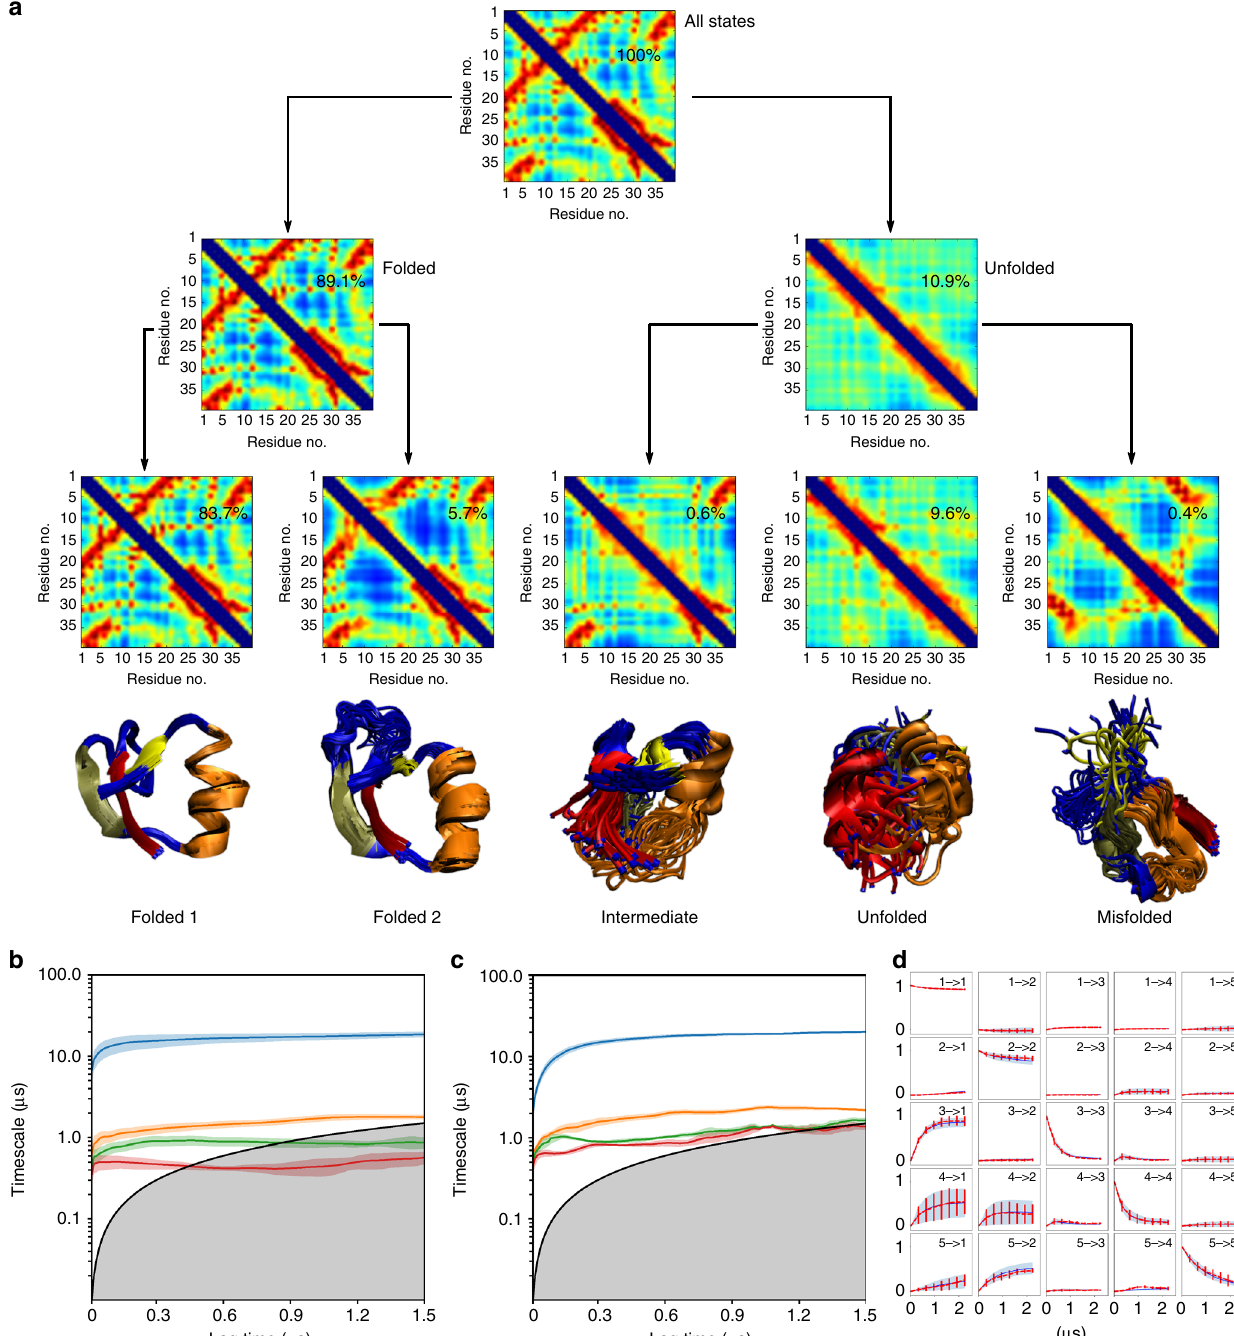
Fig. 6 VAMPnet results of NTL9-folding kinetics. a Hierarchical decomposition of the NTL9 protein state space by a network with two and fi ve output nodes. Mean contact maps are shown for all MD samples grouped by the network, along with the fraction of samples in that group. 3D structures are shown for the fi ve-state decomposition, residues involved in α -helices or β -sheets in the folded state are colored identically across the different states. b Relaxation timescales computed from the Koopman model approximated using the transformation applied by a neural network with fi ve output nodes. c Relaxation timescales from a Markov state model computed from a TICA transformation of the contact maps, followed by k-means clustering with k = 40. d Chapman – Kolmogorov test comparing long-time predictions of the Koopman model estimated at τ = 320 ns and estimates at longer lag times. b – d report 95% con fi dence interval error bars over 100 training